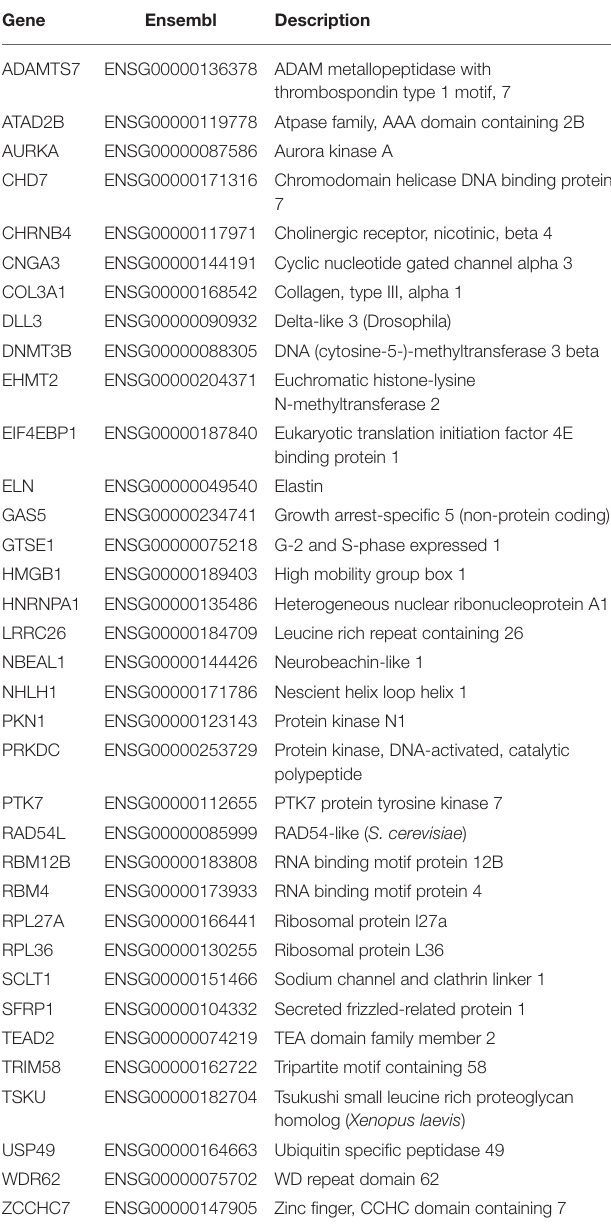
TABLE 1 | Genes selected for composing the genetic score (5-HTT-ePRS). Gene